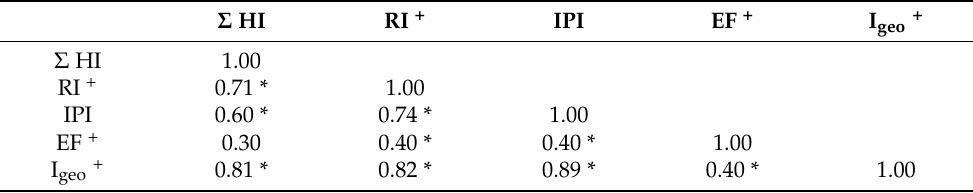
Table 5. Relationship between the characteristics of dust pollution and the human health risks. Σ HI RI + IPI EF +